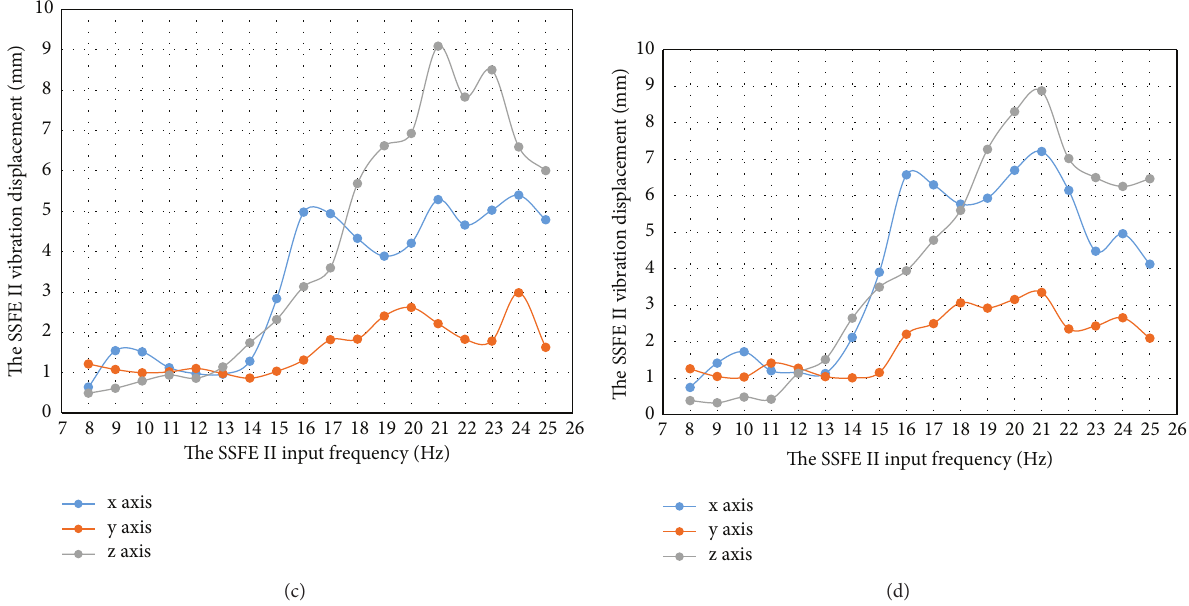
Figure 17: Under every eccentric mass, curves of the SSFE II vibration displacements along the three directions changing with the SSFE II input frequency. (a) Under a 1kg eccentric mass. (b) Under a 2kg eccentric mass. (c) Under a 3kg eccentric mass. (d) Under a 4 kg eccentric